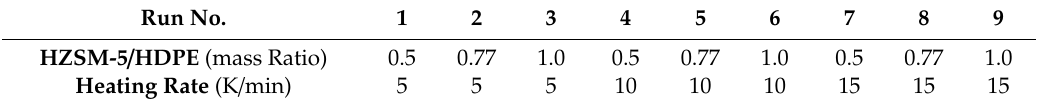
Table 3. Experimental matrix.